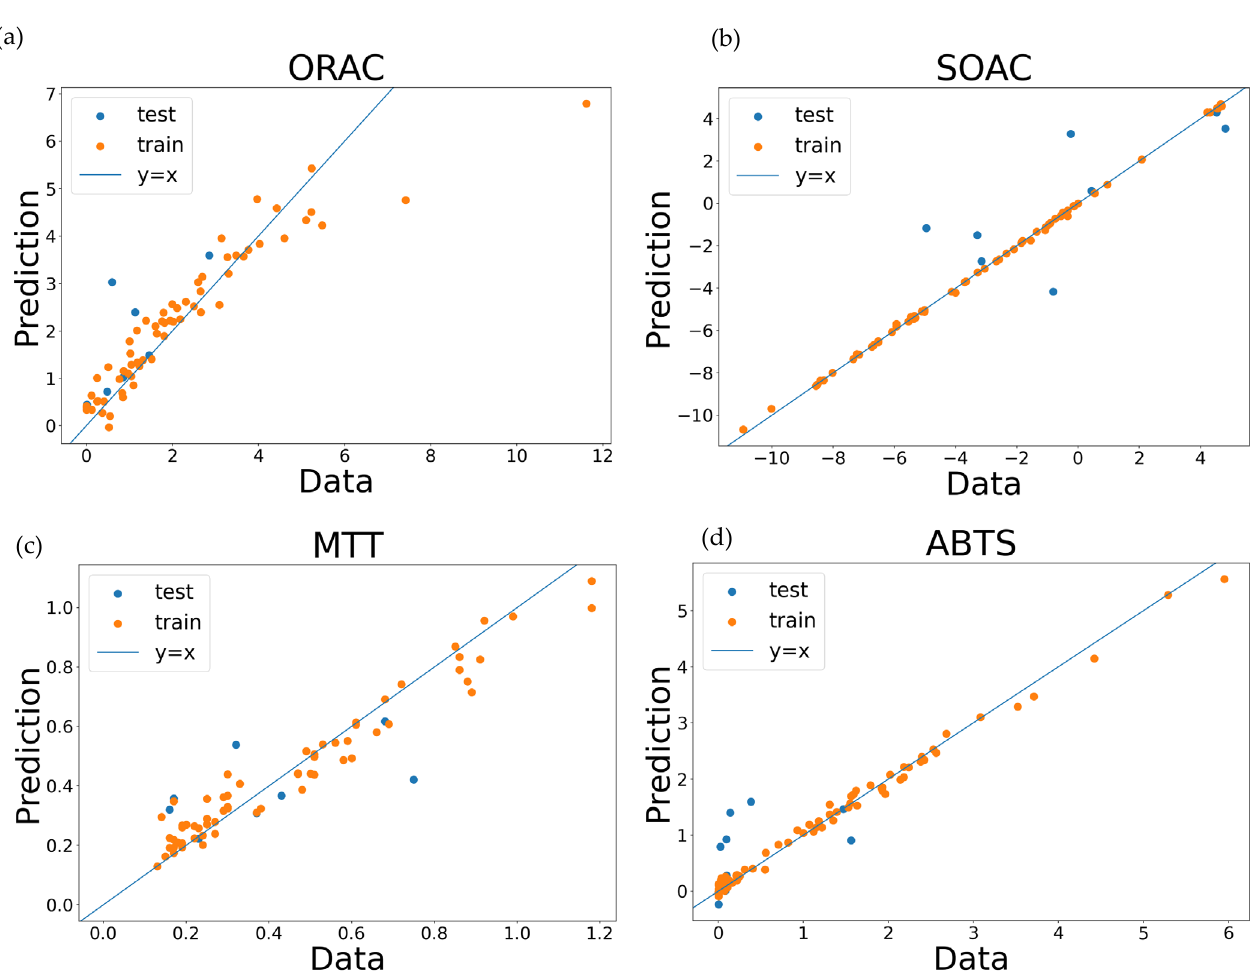
Figure 2. Prediction results at five regression tasks. The orange markers show training data, whilst the blue ones show the prediction of test data. The blue lines indicate where the plots are located when the predictions were correct. ( a ) The prediction performance when the ORAC dataset was used. ( b ) The prediction of SOAC values. ( c ) The prediction of MTT values. ( d ) The prediction of TEAC values included in the ABTS dataset. Table 4. Comparison of XGBoost and linear models based on predictive performance for test data. Ordinary least squares linear regression (OLS) models and a logistic regression model were trained with different features. MAE 18 means the MAE values of a model trained with 18 common features. MAE linear means the MAE of a model trained with input features shown in this table. Accuracy was used in the DPPH task instead of MAE. In most cases, models trained using 18 common features showed a better performance. * better performance